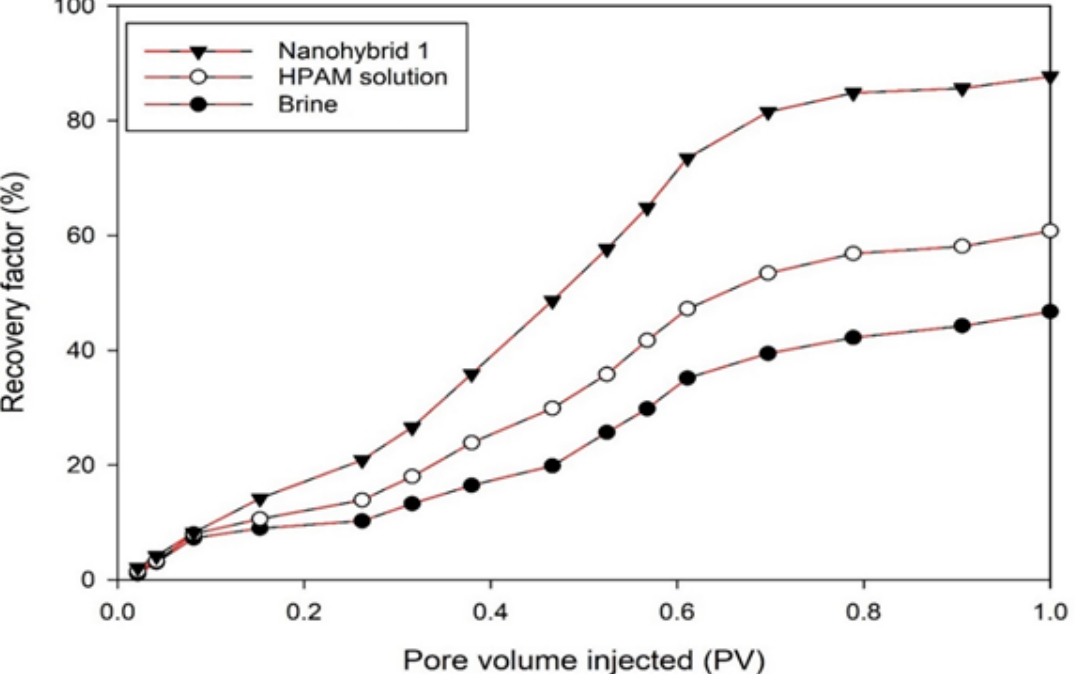
Figure 11. Oil recovery factor as a function of pore volume injection of nanohybrid 1, HPAM polymer, and brine solution.